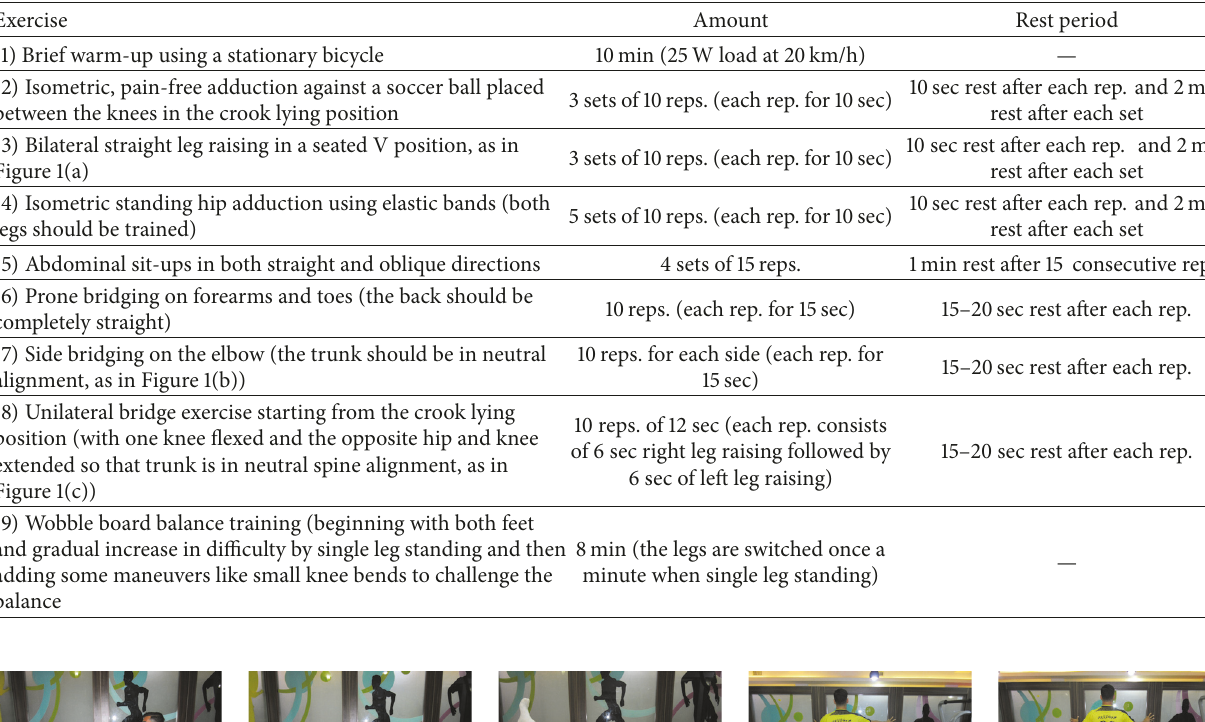
Table 1: Modified H¨olmich et al. protocol: part 1.